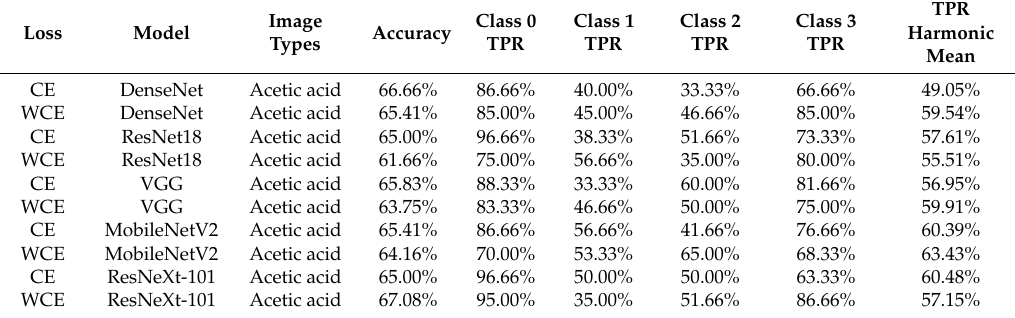
Table 9. Results for training using the weighted cross entropy versus simple cross entropy on the baselines models. The transformation applied to the errors is φ ( x ) = exp ( 100 x ) as explained in Section 3.4, except for VGG, where we applied a transformation of φ ( x ) = exp ( x ) . The training of this network did not converge having the other transformation. Some of the models trained with weighted cross entropy record better-balanced true positive rates as measured by the harmonic mean. In the table, TPR stands for true positive rate, WCE stands for weighted cross entropy, and CE stands for cross